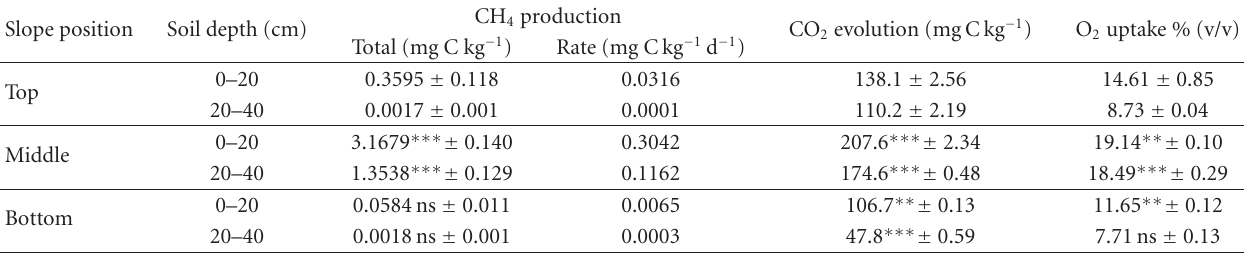
Table 2: CH 4 production, CO 2 evolution and O 2 uptake of soils collected from three slope positions, and incubated for 28 days under flooding (average values ± standard error, n =